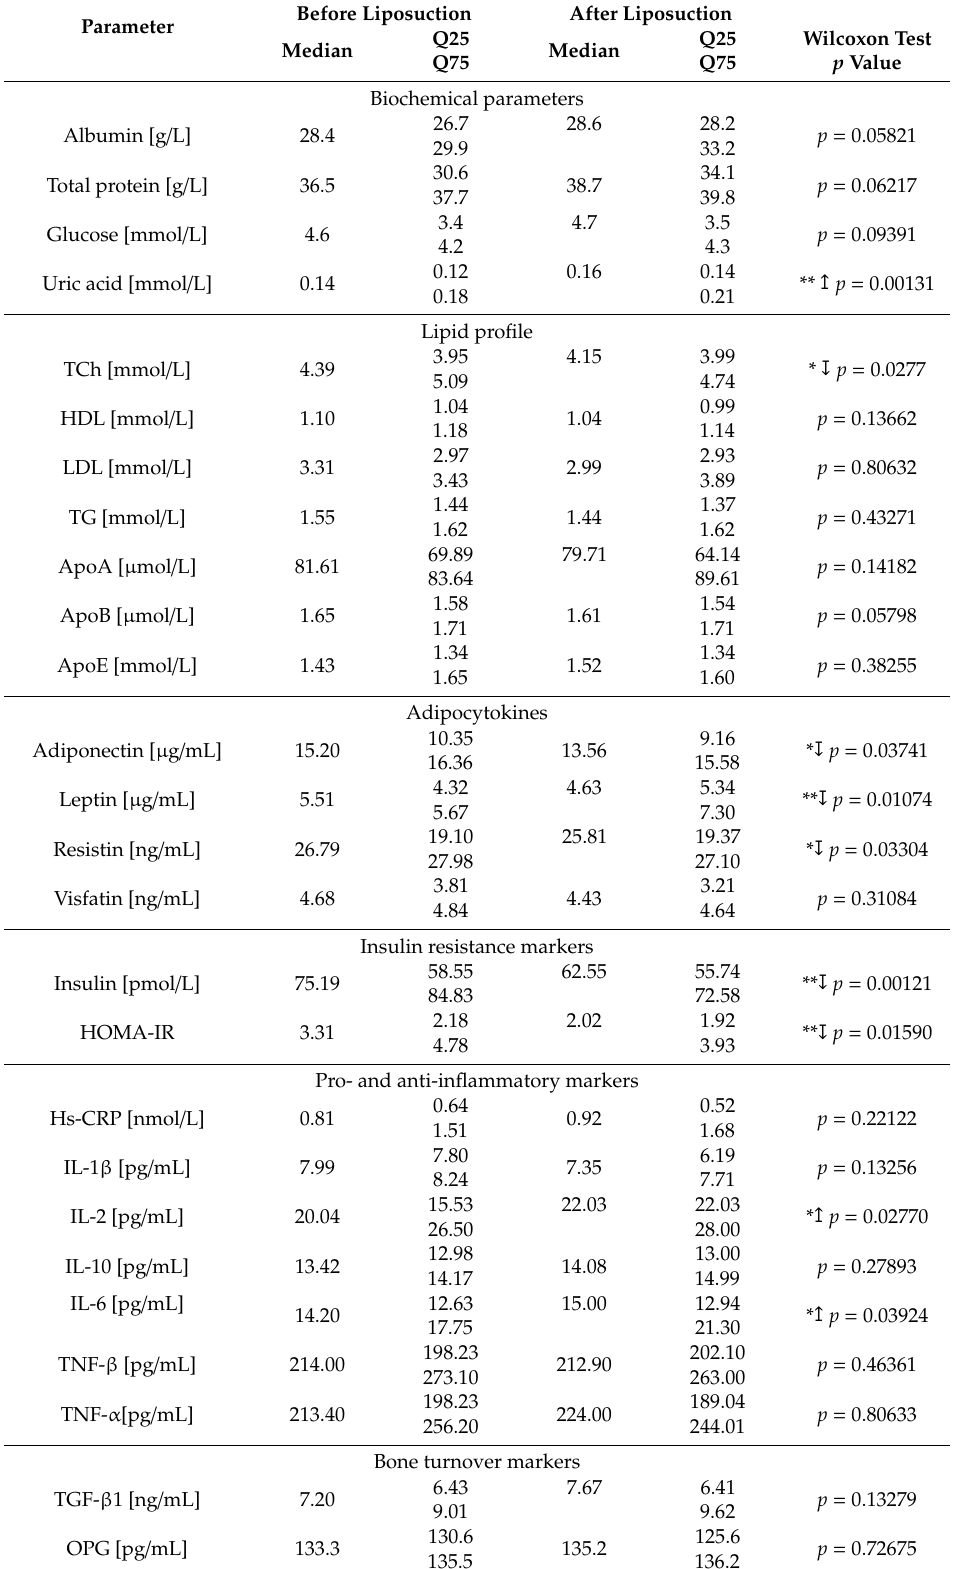
Table 3. Changes in blood biochemical parameters in response to small-volume liposuction of subcutaneous abdominal fat. Table 1. The baseline values of haematological parameters in the examined women.